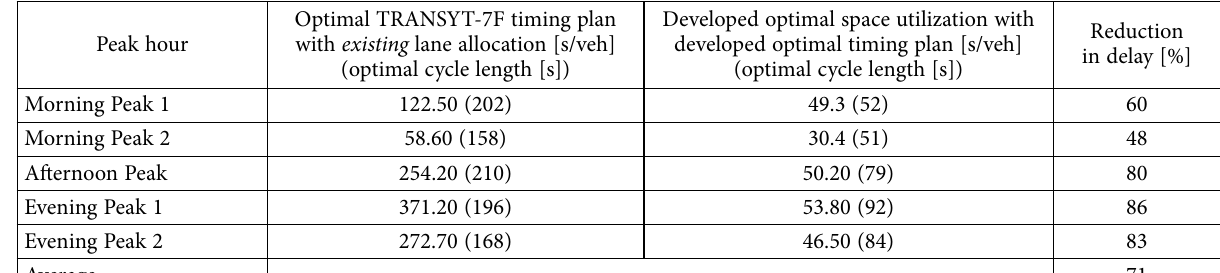
Table 2. SIMTRAFFIC simulation of average intersection delay for the proposed process and TRANSYT-7F Peak